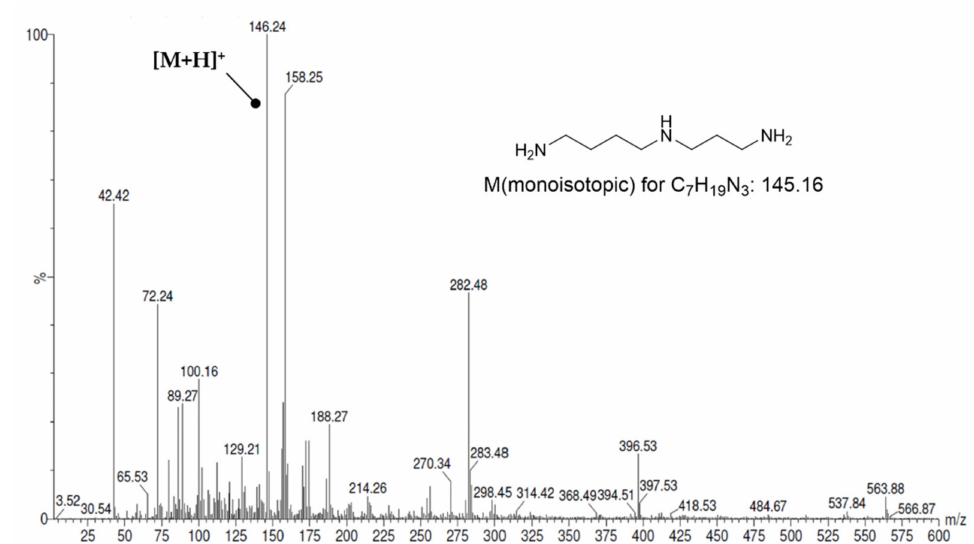
Figure 3. ESI(+) mass spectrum of spermidine obtained after reduction of resin-bound 3- oxospermidine ( IV